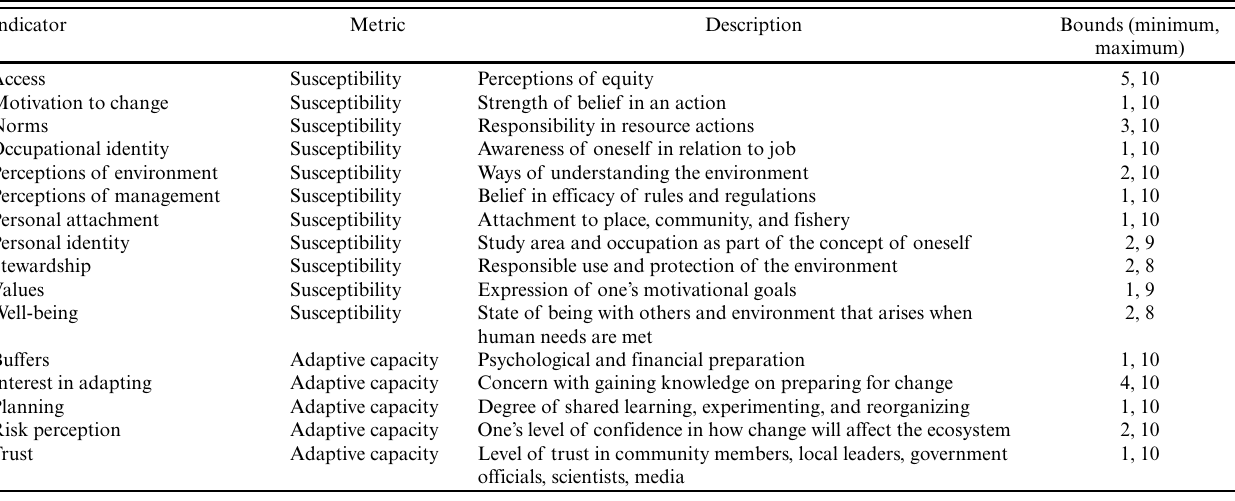
Table 1. Indicators of susceptibility and adaptive capacity used for our study, including the minimum and maximum (continuous) values reported from the dataset used for